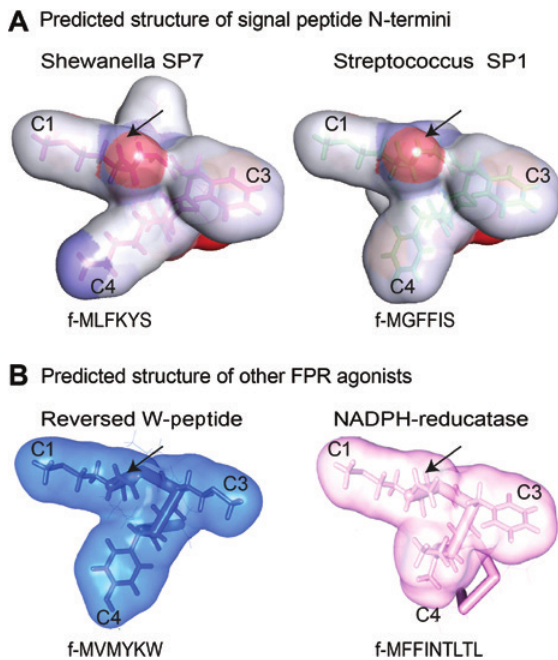
Figure 4: Comparison of the structural features of bacterial signal peptides with other FPR agonists. ( A) Molecular models of the charge distribution and molecular surface of two similarly potent bacterial signal peptides, SP7 from the TonB-dependent siderophore receptor of Shewanella baltica and SP1 from the hyaluronate lyase of Streptococcus suis . Correspond- ing amino acid sequences are depicted below each model. Black arrows indicate the position of the formyl group that is attached to the N-terminal α -C-atom (C1) of the first amino acid. C3 and C4 indicate functional groups attached to α -C-atoms of the third and fourth amino acid. Polar regions with a positive charge are depicted in blue, negative charges are shown in red, hydrophobic regions are shown in gray. Note that both sequence-divergent bacterial signal peptides display a similar claw-like 3D structure with a conserved hydrophobic surface. The only conserved polar position is the formyl group. Charge distributions in the amino acid side chains differ, which argues against a prominent role of polar interactions with these residues. (B) The 3D structure of the synthetic reversed W-peptide (blue) and the mitochondrial NADH reductase subunit 1 (pink), which are also potent FPR activators (19). Note that the shape of both structures shows obvious similarities to the bacterial signal peptides shown in panel